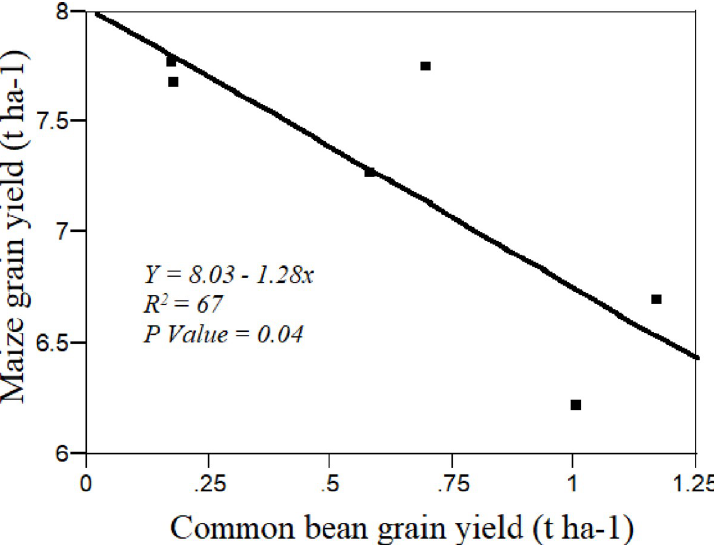
Table 5. Partial and total land equivalent ratios for maize-common bean intercropping at Adet research station, Northwestern Ethiopia a . Treatments Grain yield Land use efficiency MAI PDCB Maize